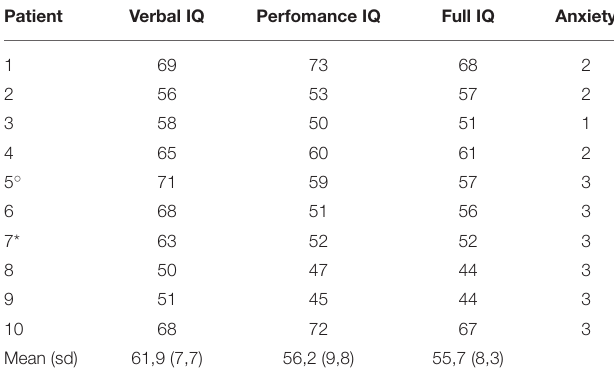
TABLE 1 | Demographic characteristics of all participants with